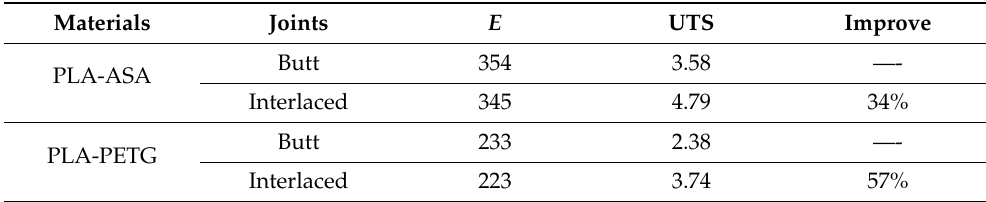
Table 3. Tensile test data for different material combinations and joint configurations. The unit for E and UTS is MPa.